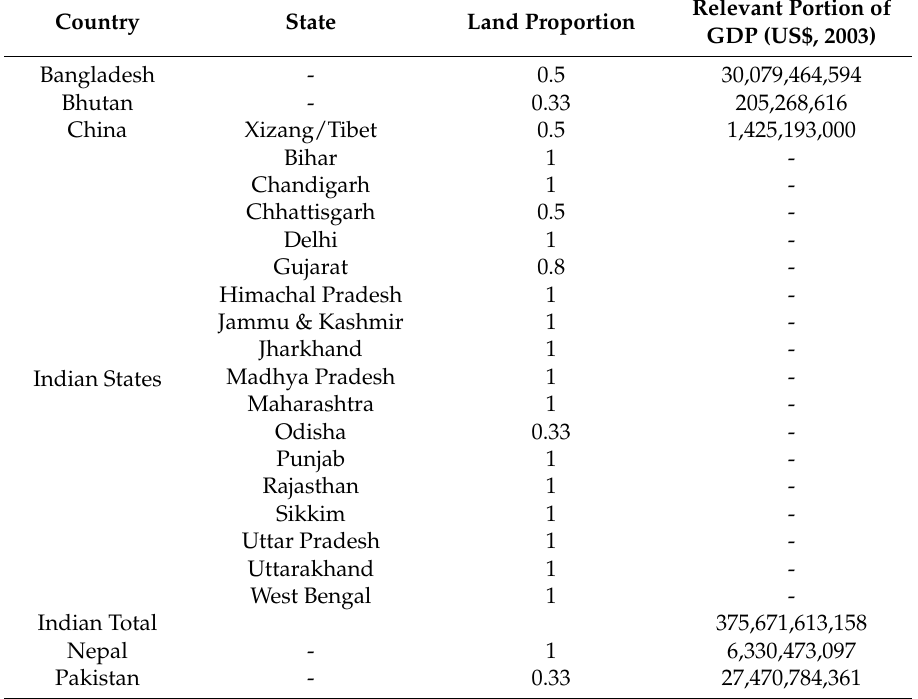
Table A1. Relevant portion of GDP as per the proportion of land area included in the ISMR catchment area based on data from [20] and a visual judgment of the proportion of the country or state included in the area. Country State Land